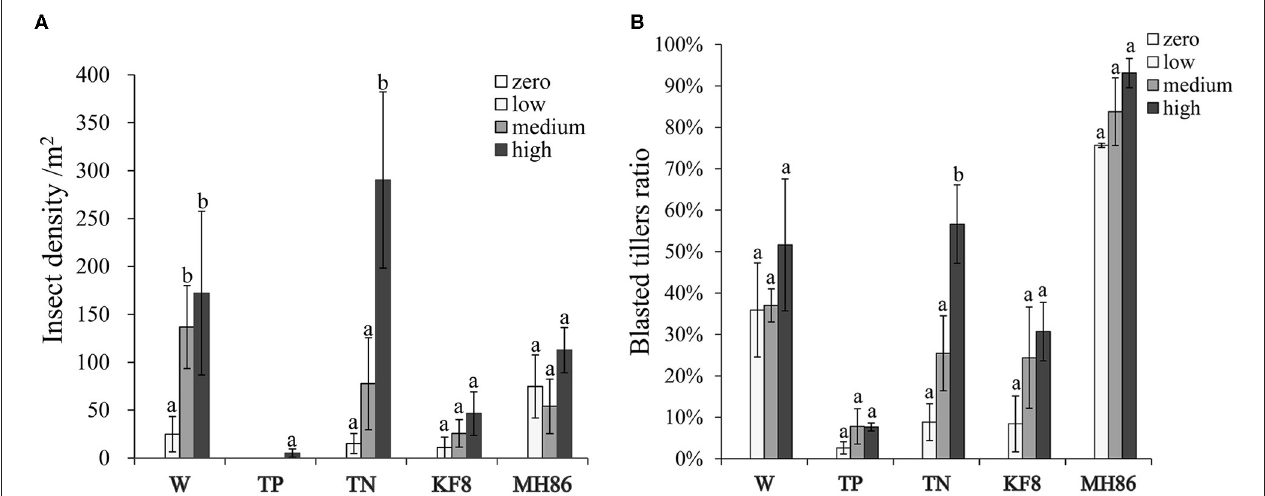
FIGURE 1 | The final insect density (A) and percentage of blasted tillers (B) in populations of wild rice (W), transgenic and non-transgenic hybrids (TP, TN), and transgenic and non-transgenic rice lines (KF8, MH86) under different insect infestation intensities. Bars represent the standard error. Different letters denote